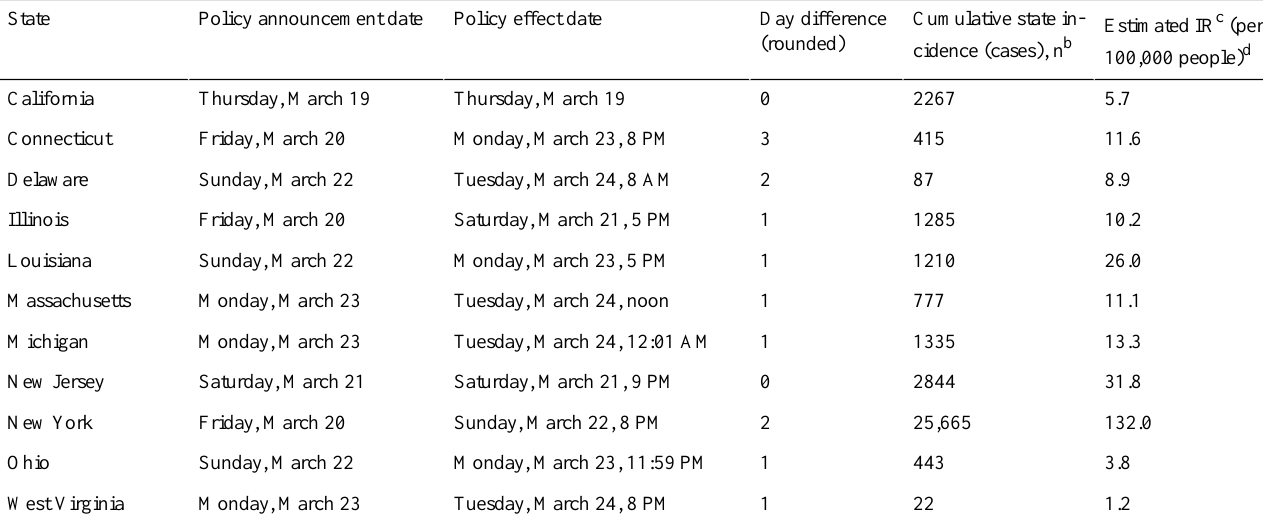
Table 1. States with stay-at-home orders as of the date of data collection.